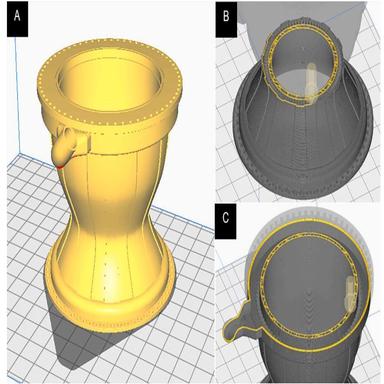
(A) Design of the liquid-fuel cryogenic rocket engine combustion chamber (B) CNC robot toolpath showing the manufacture of the outer casing and (C) CNC toolpath of the hollow fuel heating/chamber cooling manifold.